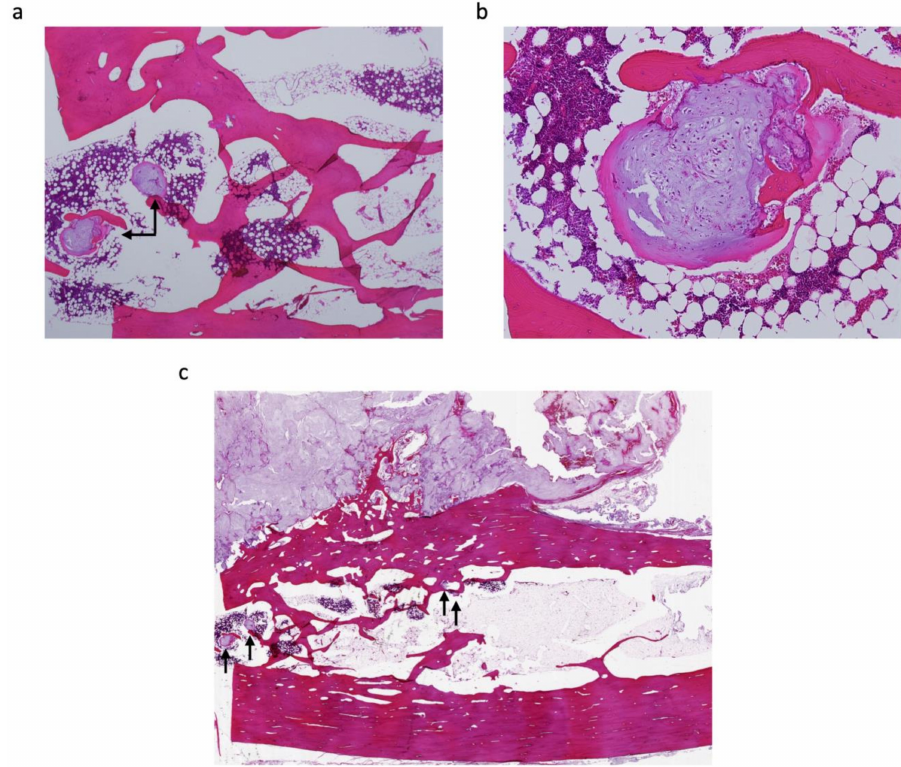
Figure 4. Histopathological sections (haematoxylin & eosin stain) from Case 4; a grade I periosteal chondrosarcoma. ( a ) Tumour cells invading the medullary cavity (black arrow) ( × 20). ( b ) Atypical chondrocytes embedded in the myxoid matrix ( × 100). ( c ) Skip lesions from the periosteal tumour invading the medullary cavity (black